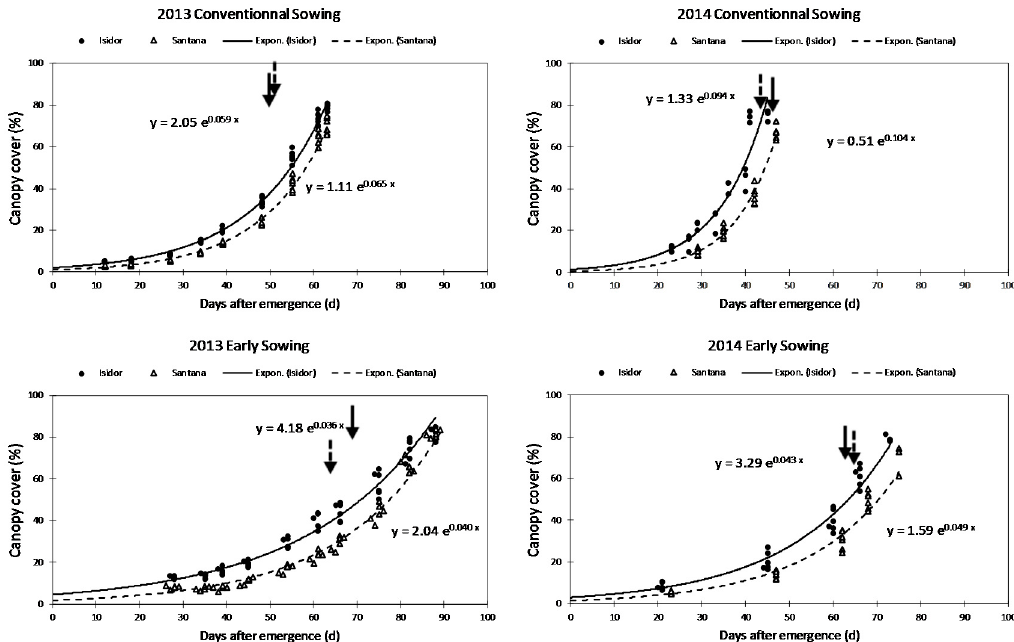
Figure 5. Canopy cover dynamics of cvs. Isidor and Santana for early and conventional sowings in 2013 and 2014. Arrows indicate the R1 stage. The solid and dashed lines represent the fitted exponential functions of canopy cover for cvs. Isidor and Santana, respectively.